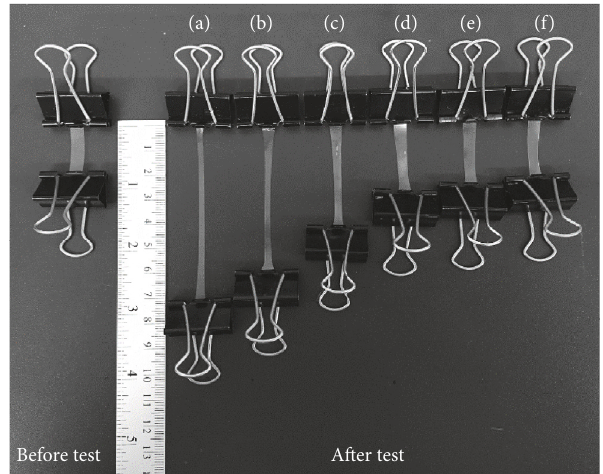
Figure 6: Dimensional stability to heat at 80 ∘ C for 30 sec under 200 g load of blend films with PLLA-PEG-PLLA/PDLA-PEG-PDLA ratios of (a) 100/0, (b) 90/10, (c) 80/20, (d) 70/30, (e) 60/40, and (f) 50/50 (w/w).